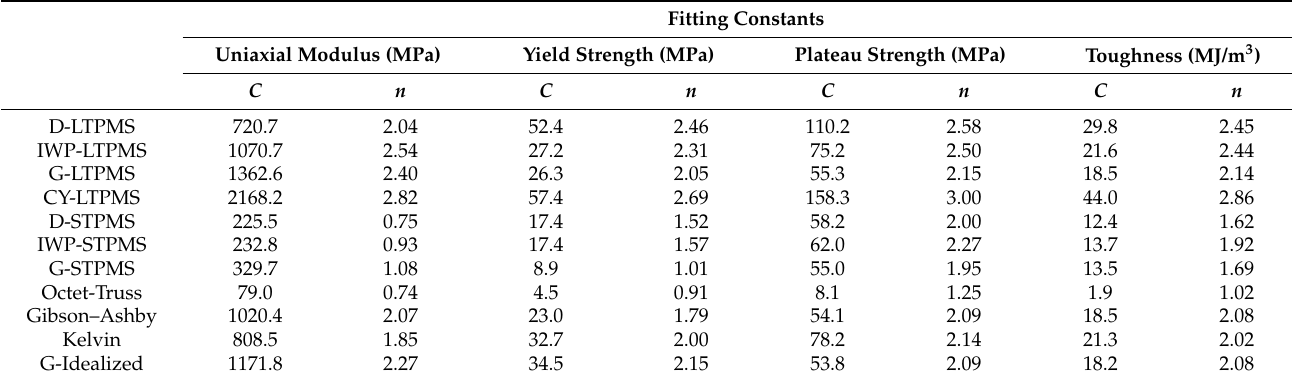
Table 5. Fitting parameters of the power scaling law in Equation (1) for various compressive mechan- ical